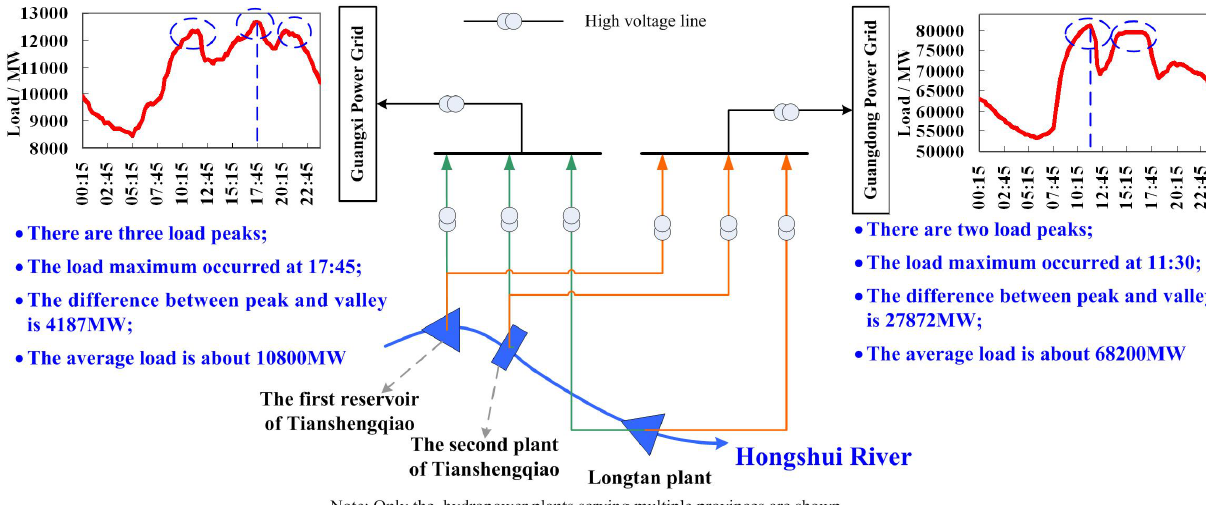
Figure 1. An example of cascaded hydropower plants serving multiple